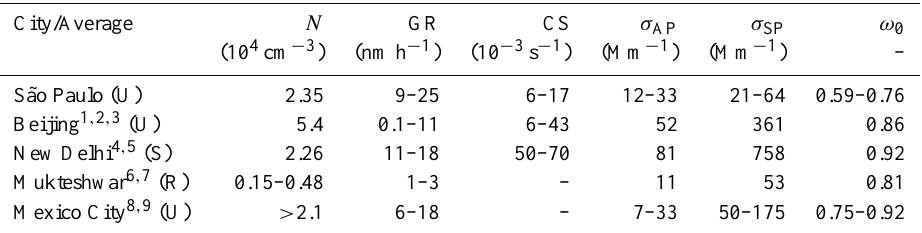
Table 1. Summary of observed, measured, and calculated aerosol parameters. The single values shown represent the averages and the two values the range of observations. The cities presented are S˜ao Paulo – Brazil, Beijing – China, New Delhi – India, Wukteshwar – India, and Mexico City – Mexico. The surroundings of the sites were classified into Urban (U), Sub-urban (S), and Remote (R) locations. N : number concentration, GR: growth rate, CS: condensation sink, σ AP : absorption coefficient, σ SP : scattering coefficient, ω 0 = single-scattering albedo. The optical properties are at λ = 637nm unless stated otherwise